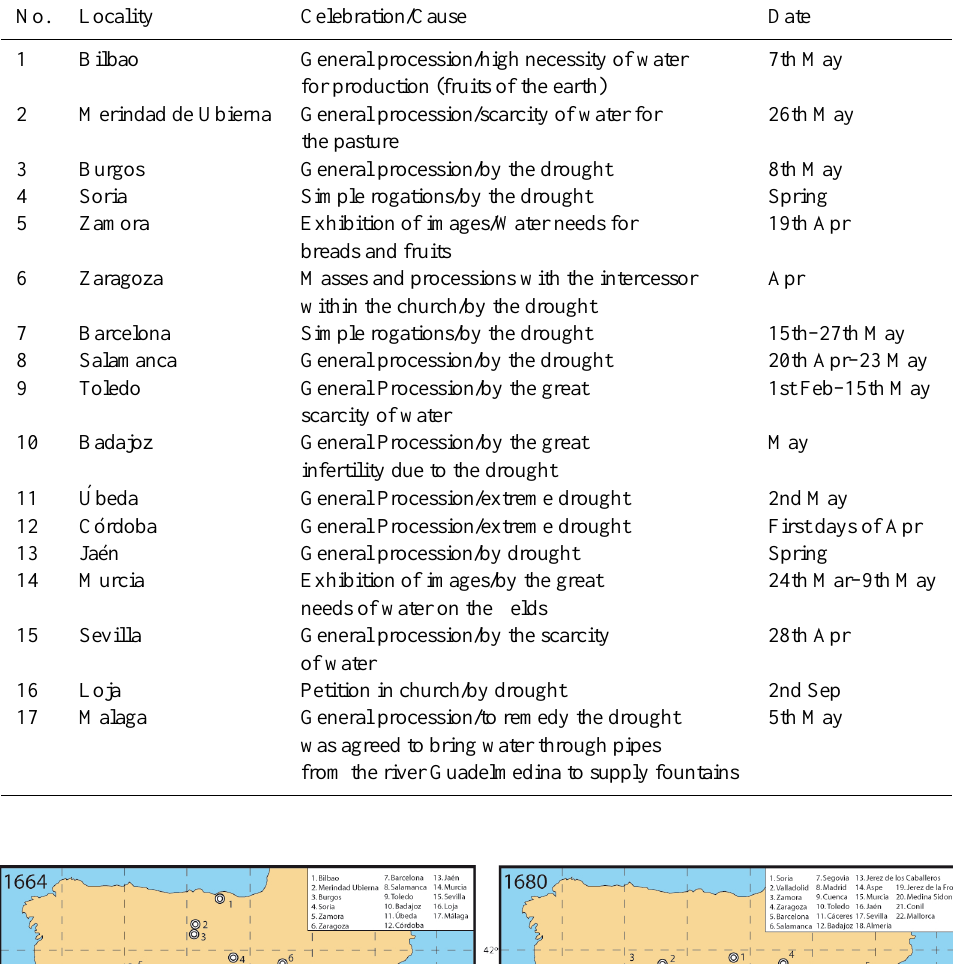
Table 1. Sites with a drought documentarily registered in spring 1664, location, date and detail about the information extracted.